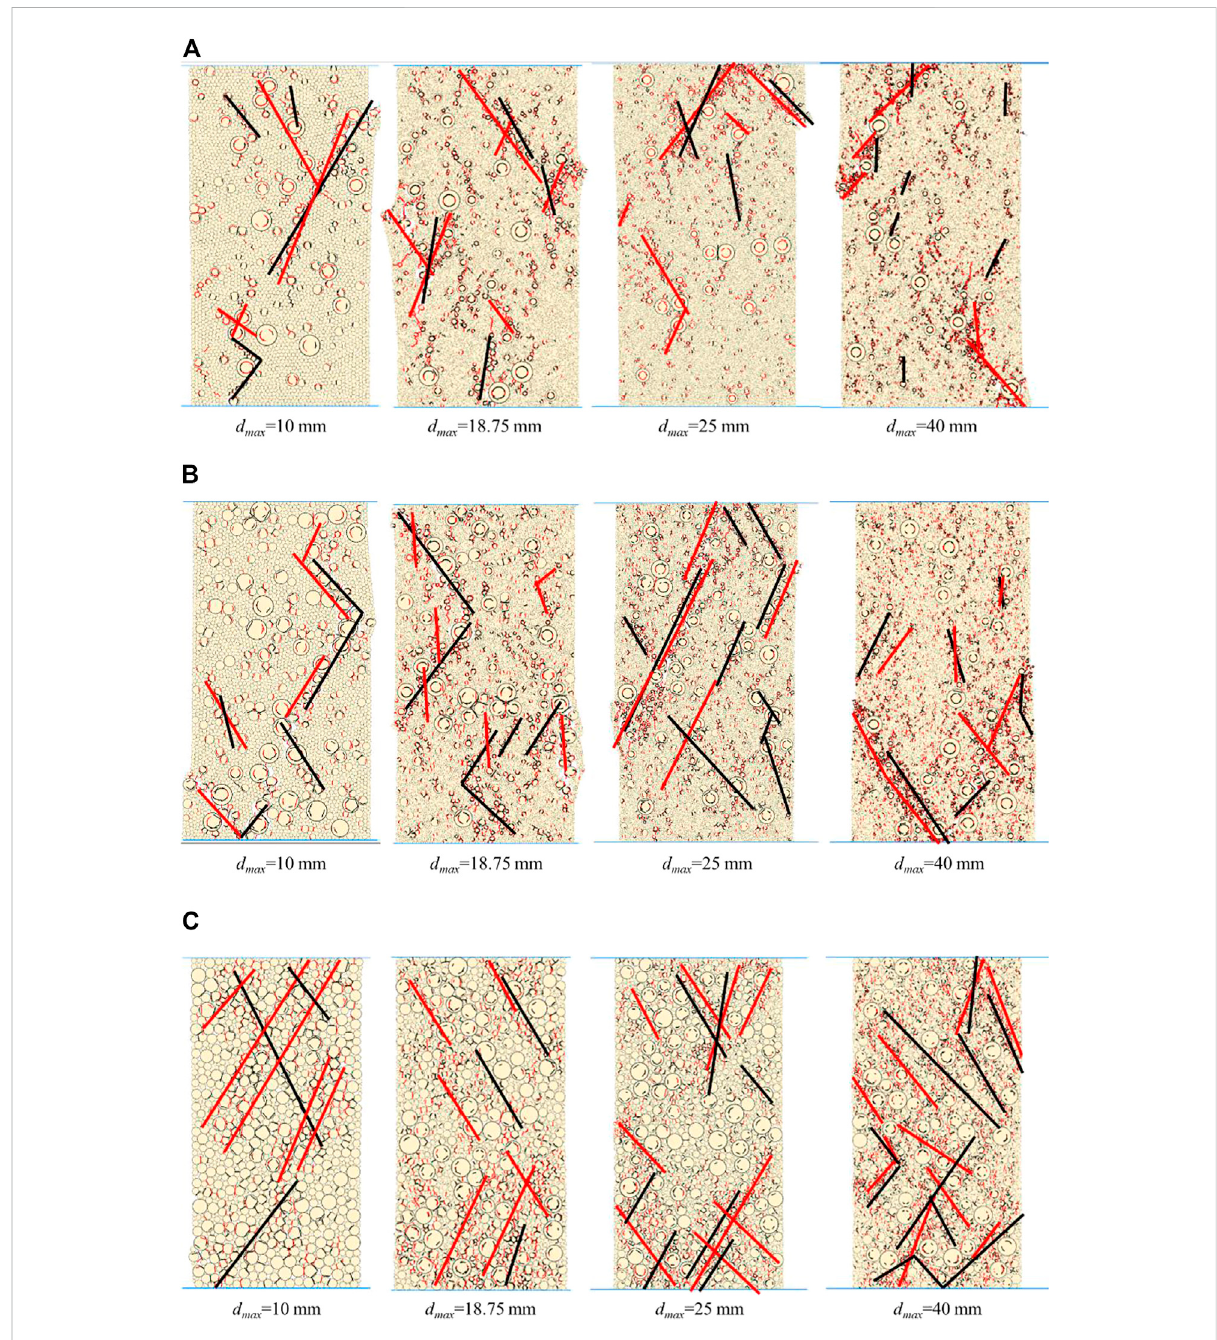
FIGURE 6 Micro-crack distribution of the sample with different d max values with (A) 20%; (B) 40%; (C) 90% VBP at the destruction